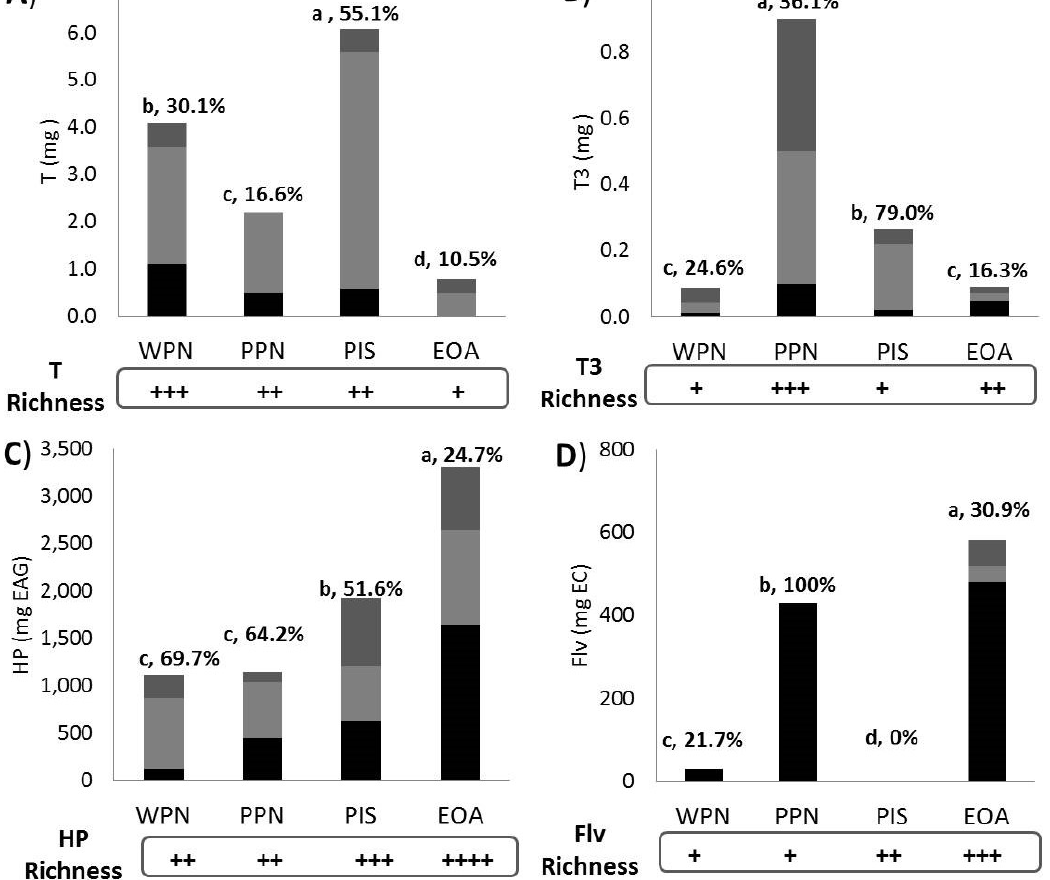
Figure 5. In vitro bioaccessibility of antioxidant phytochemicals from selected edible nuts. Label: